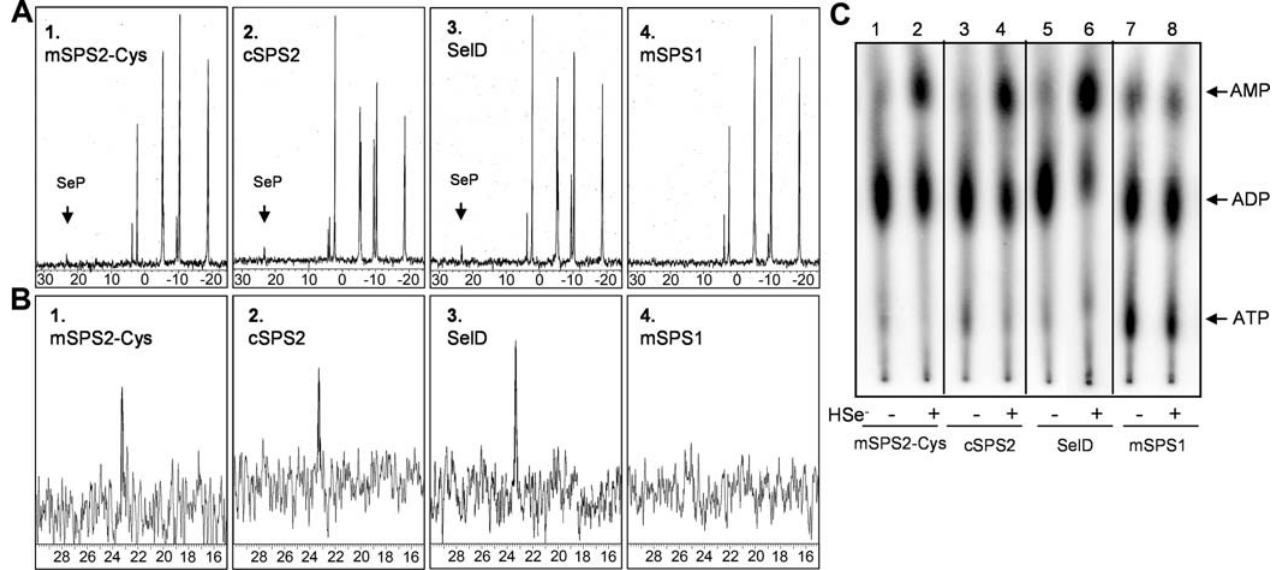
Figure 4. In Vitro ATP Hydrolysis Assay of Selenophosphate Synthetase and NMR Spectroscopic Analysis Cloning of the genes, mouse sps1, mouse sps2, SelD, and C. elegans sps2, and mutation of mouse sps2 to sps2-Cys and reaction conditions are detailed in Materials and Methods. For NMR analysis, 200 l l of ATP hydrolysis reaction was sealed in 3-mm NMR tubes and incubated at 37 8 C for 4 h before 31 P NMR spectroscopic analysis [9]. (A) Complete 31 P-NMR spectra of ATP hydrolysis products generated with mSPS2-Cys, C. elegans selenophosphate synthetase 2, SelD, and mSPS1 are shown. (B) Expanded spectra of the ordinate and abscissa between 15 and 30 ppm for these products are shown. (C) ATP hydrolysis reactions with [ a - 32 P]ATP, either without or with 0.25 mM selenide, incubated with mSPS2-Cys, C. elegans selenophosphate synthetase 2, SelD, or mSPS1; at the end of the incubation period, reactions were loaded onto PEI TLC plates, run in 0.8 M LiCl, and exposed to a PhosphorImager screen as described in Materials and